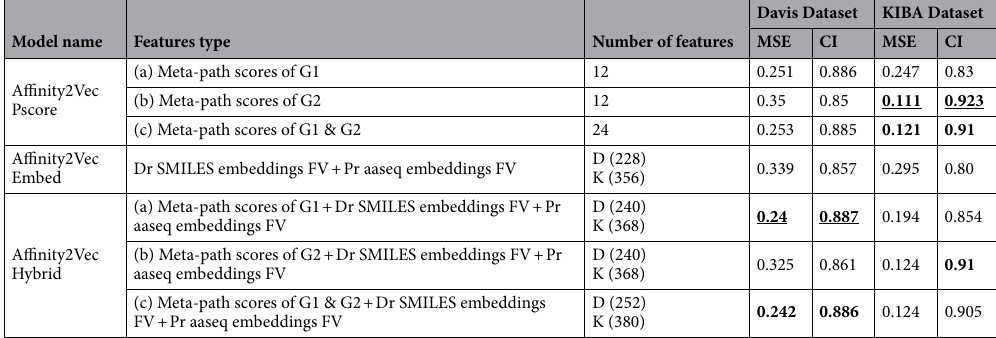
Table 3. Best-obtained results among all variants of Affinity2Vec for Davis & KIBA datasets in term of MSE and CI. Bold font with underline indicates the best results, and bold font alone shows the second-best results. Dr Drugs, Pr proteins, aaseq amino-acid sequence, D Davis dataset, K KIBA dataset. G1 consists of (DTBA training part, DDsim1 2D chemical structures similarity, TTsim1 targets’ sequence alignment similarity using normalized Smith-waterman scores), G2 consists of (DTBA training part, DDsim2 drugs’ SMILES embeddings cosine similarity, TTsim2 targets’ sequence embeddings cosine